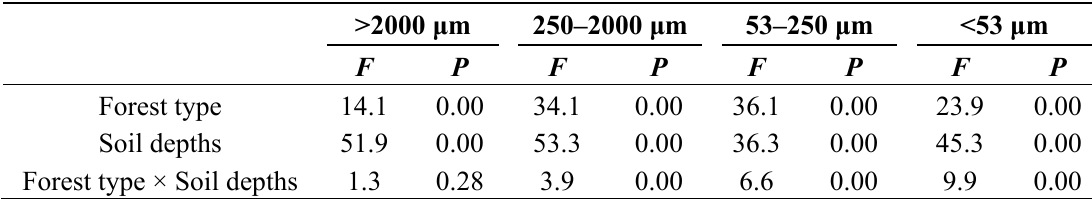
Table 5. Significance of the effects of forest type, soil depths, and forest type × soil depths on the content of water-stable aggregate particulate organic carbon in the two-way analysis of variance (ANOVA).